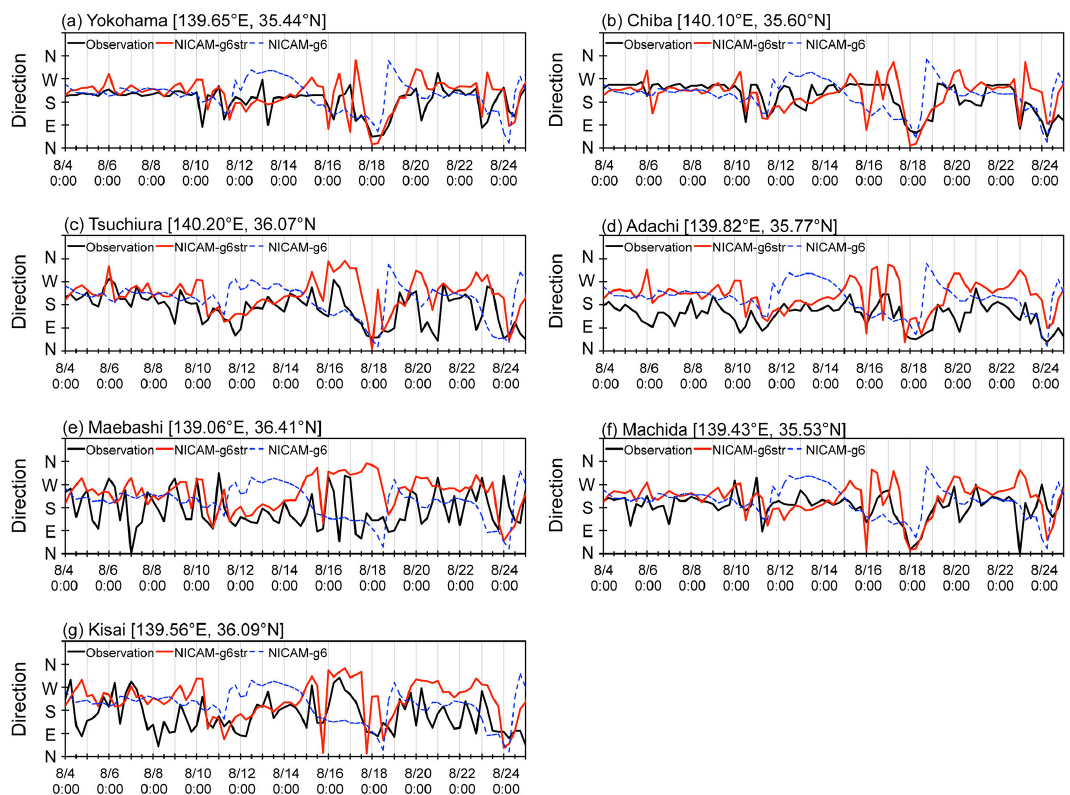
Figure 6. Same as Fig. 4 but for wind